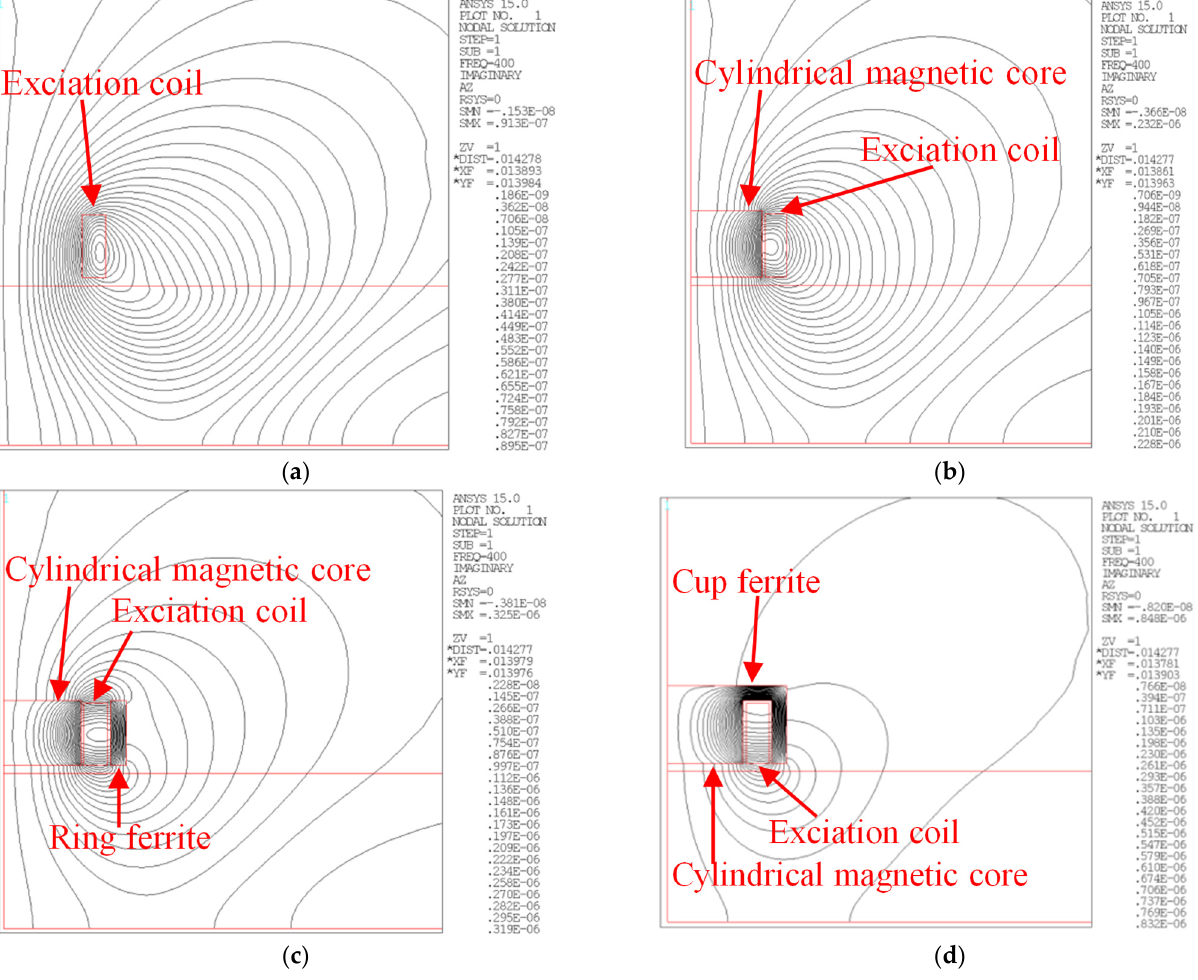
Figure 6. Distribution of magnetic lines of force of different magnetic circuit models. ( a ) Model 1; ( b ) Model 2; ( c ) Model 3; ( d ) Model 4.